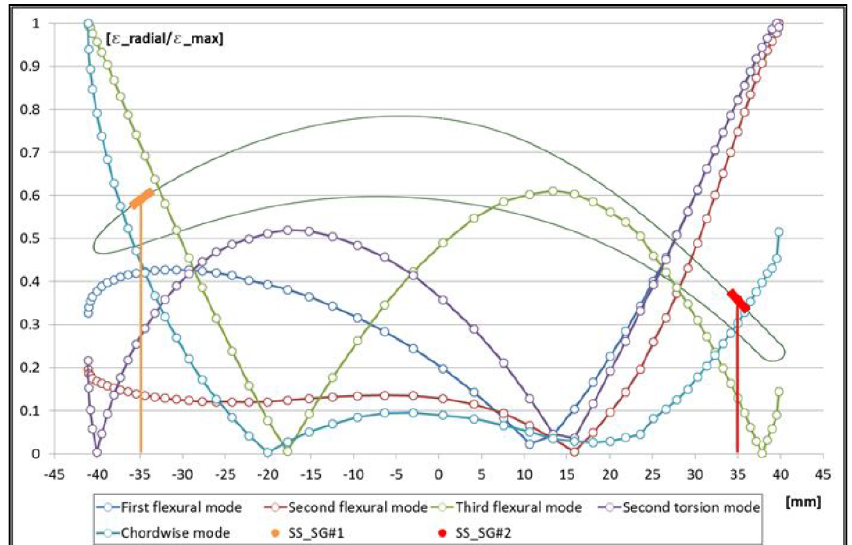
Figure 5. Normalized radial deformations on LSMB along the suction side of the